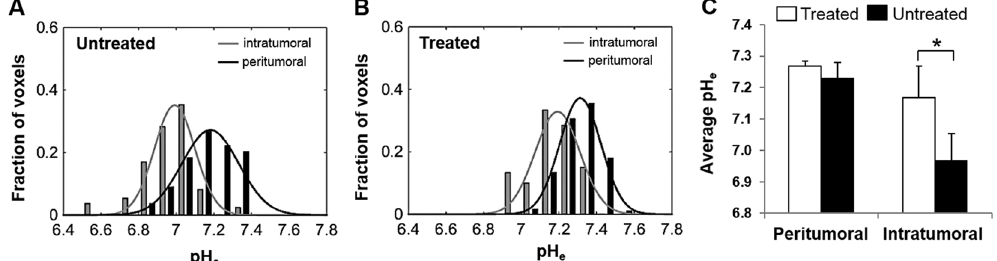
Figure 3. Distribution of pH e values in intratumoral (gray bars) and peritumoral (black bars) regions for untreated (A) and TMZ treated (B) U251 tumors. Average pH e values ( ± SD) for intratumoral and peritumoral regions in untreated and TMZ treated U251 tumors (C) show that the average pH e value for intratumoral voxels is significantly lower in untreated tumors compared to treated tumors ( * p =